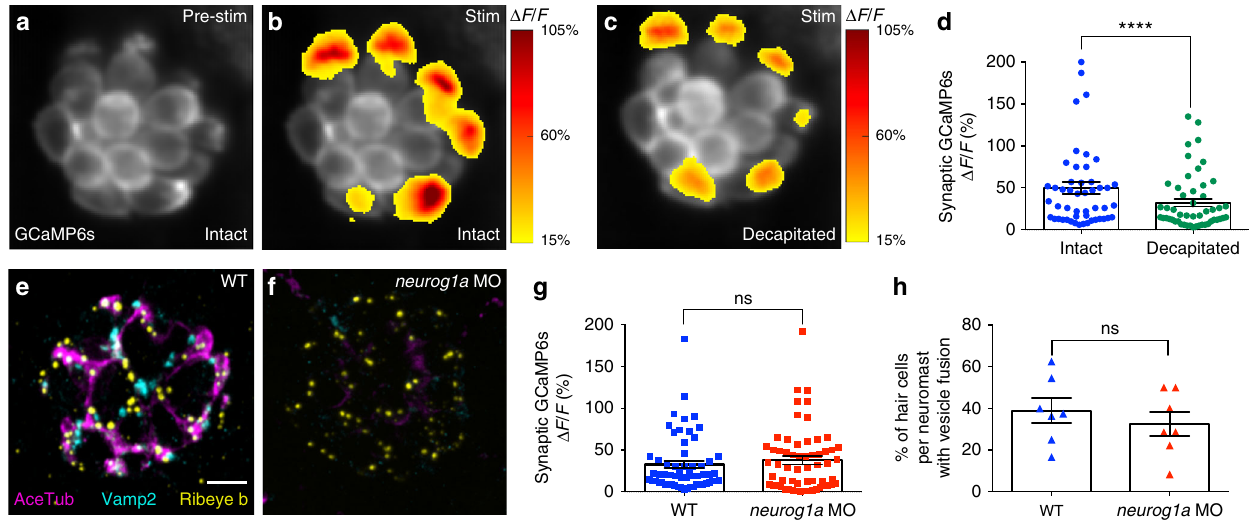
Fig. 4 The proportion of active cells is not dependent on innervation. a – c Presynaptic Ca 2 + pro fi les of a representative neuromast in response to a 2-s 5 Hz (anterior – posterior directed square wave) stimulus that activates all hair cells, before ( b ) and after decapitation to eliminate efferent activity ( c ). Spatial patterns of GCaMP6s Ca 2 + activities during stimulation are colorized according to the Δ F / F heat map and superimposed onto the baseline GCaMP6s image ( a ). d Presynaptic Ca 2 + responses before (49.90% ± 7.24) and after decapitation (32.31%± 4.70), n = 50 cells, p < 0.0001. Immunostaining of a wild-type (WT, e ) and neurog1a morphant (MO, f ) neuromast. Ribeye b labels presynaptic ribbons (yellow), Acetylated Tubulin (AceTub, magenta) labels afferent neurons, and Vamp2 (cyan) labels efferent neurons. The neurog1 morphants lack afferent (magenta) and efferent (cyan) innervation. g There is no signi fi cant difference in the magnitude of the presynaptic Ca 2 + responses between the WT (32.64%± 4.36) and neurog1a morphants (37.73% ± 4.93), n = 59 hair cells, p = 0.79. h There is no signi fi cant difference in the percentage of hair cells with vesicle fusion per neuromast between WT (38.94% ± 5.97) and neurog1a morphants (32.53%± 5.75), n = 7 neuromasts, p = 0.45. A Wilcoxon test was used in d , a Mann – Whitney test in g , and an